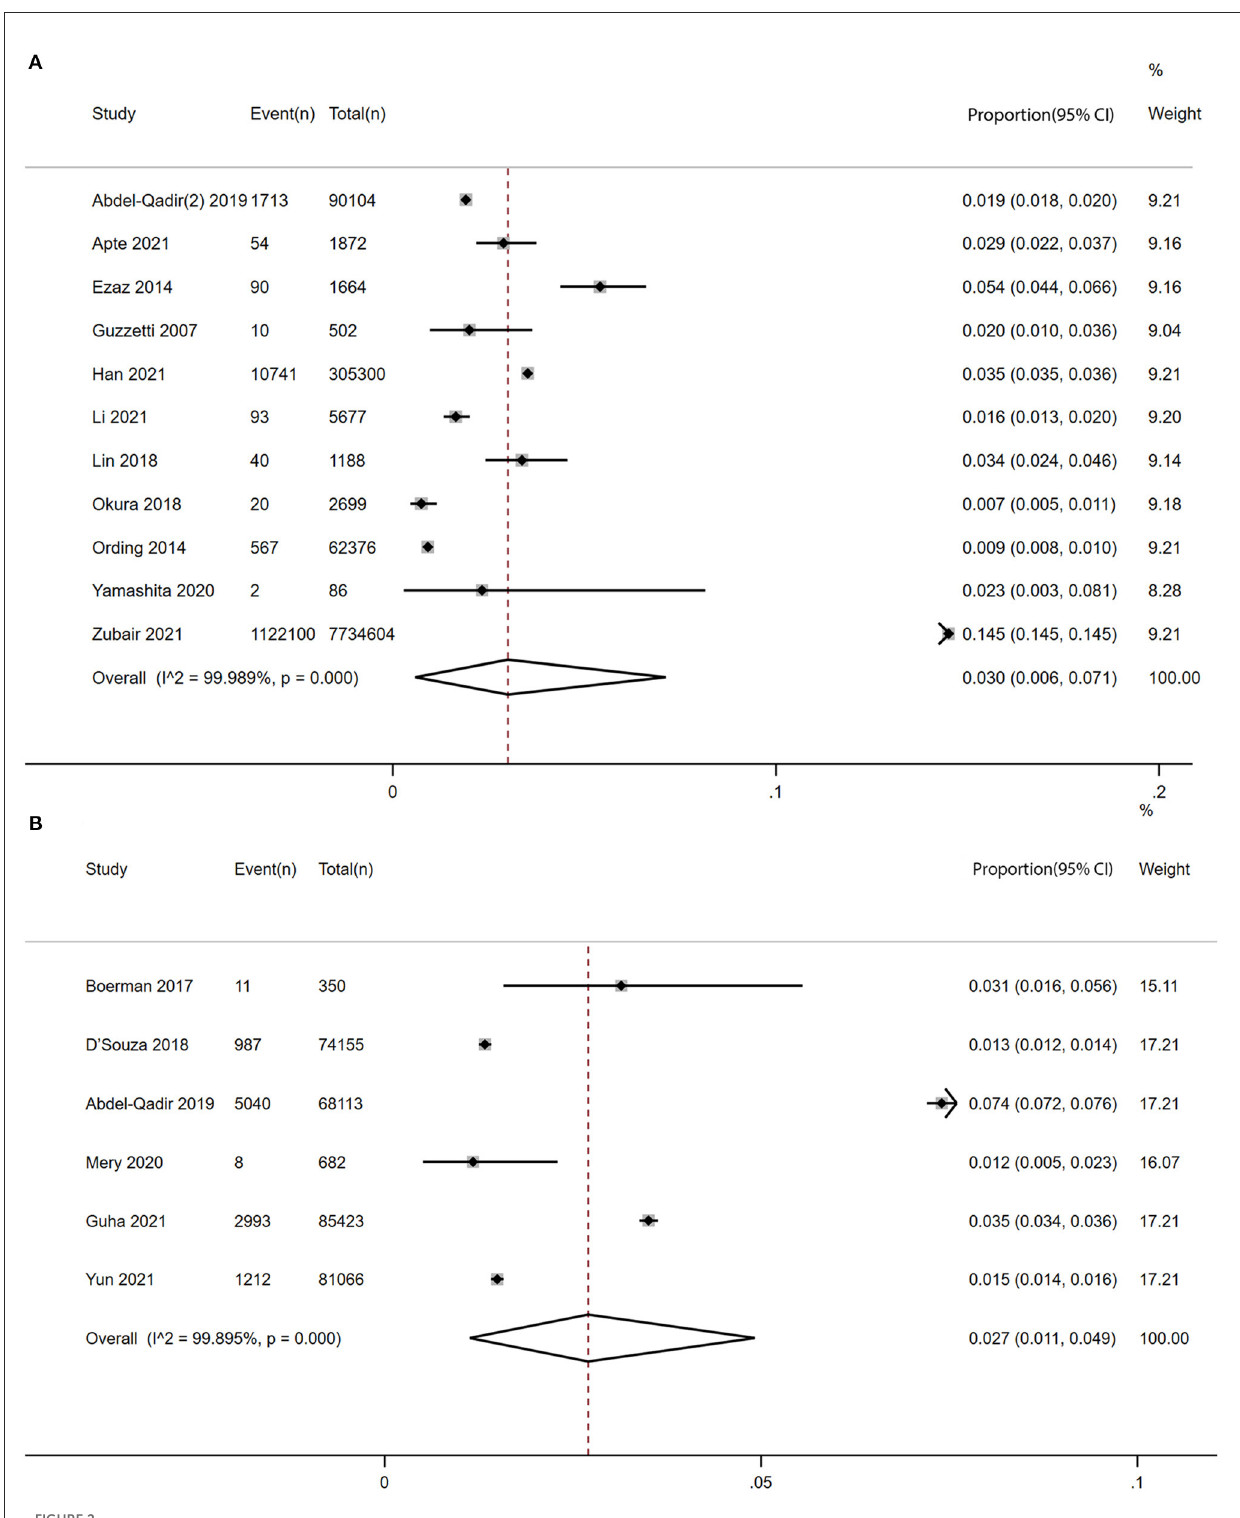
greater number of atrial fibrillation cases ( ≥ 50) than among breast cancer patients (1.9%) in studies with a smaller number of atrial fibrillation cases ( < 50) (Figure 3D). However, there were